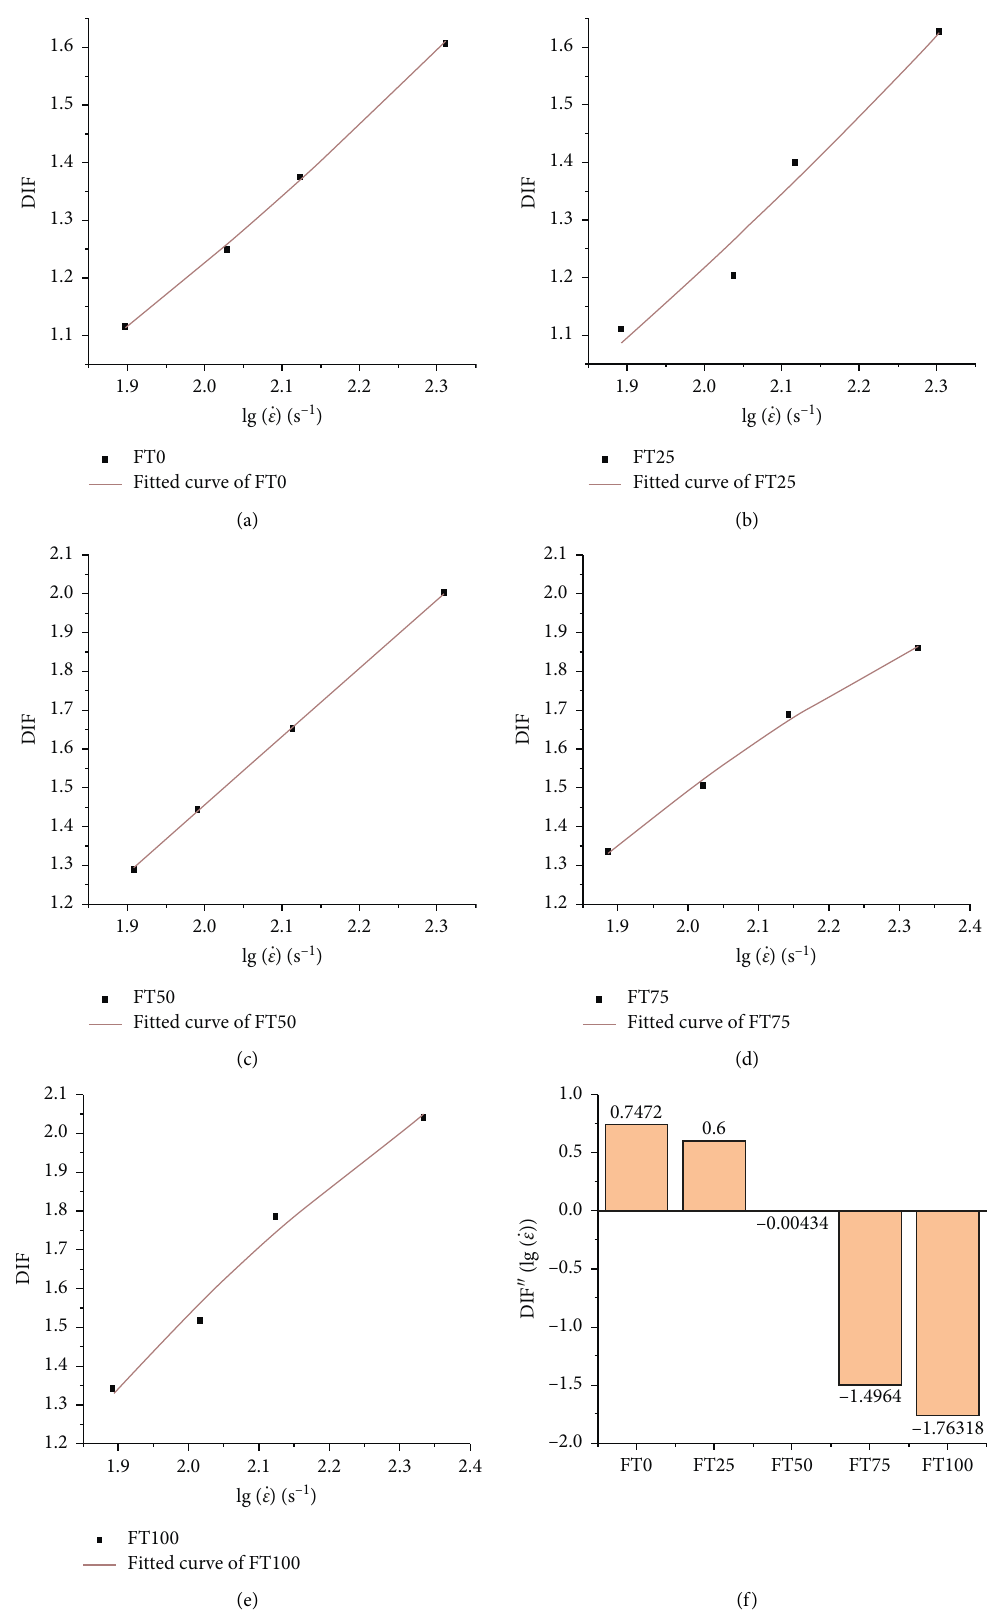
Figure 11: Relationship curve between DIF and lg _ ε . (a) FT0. (b) FT25. (c) FT50. (d) FT75. (e) FT100. (f) Second derivative value of